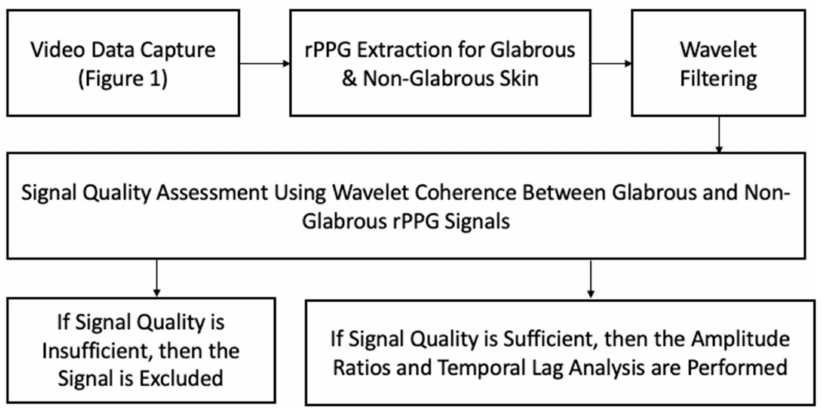
Figure 5. Diagram of the signal processing flow, beginning with data capture and rPPG extraction, and proceeding to filtering, signal quality assessment, and calculation of